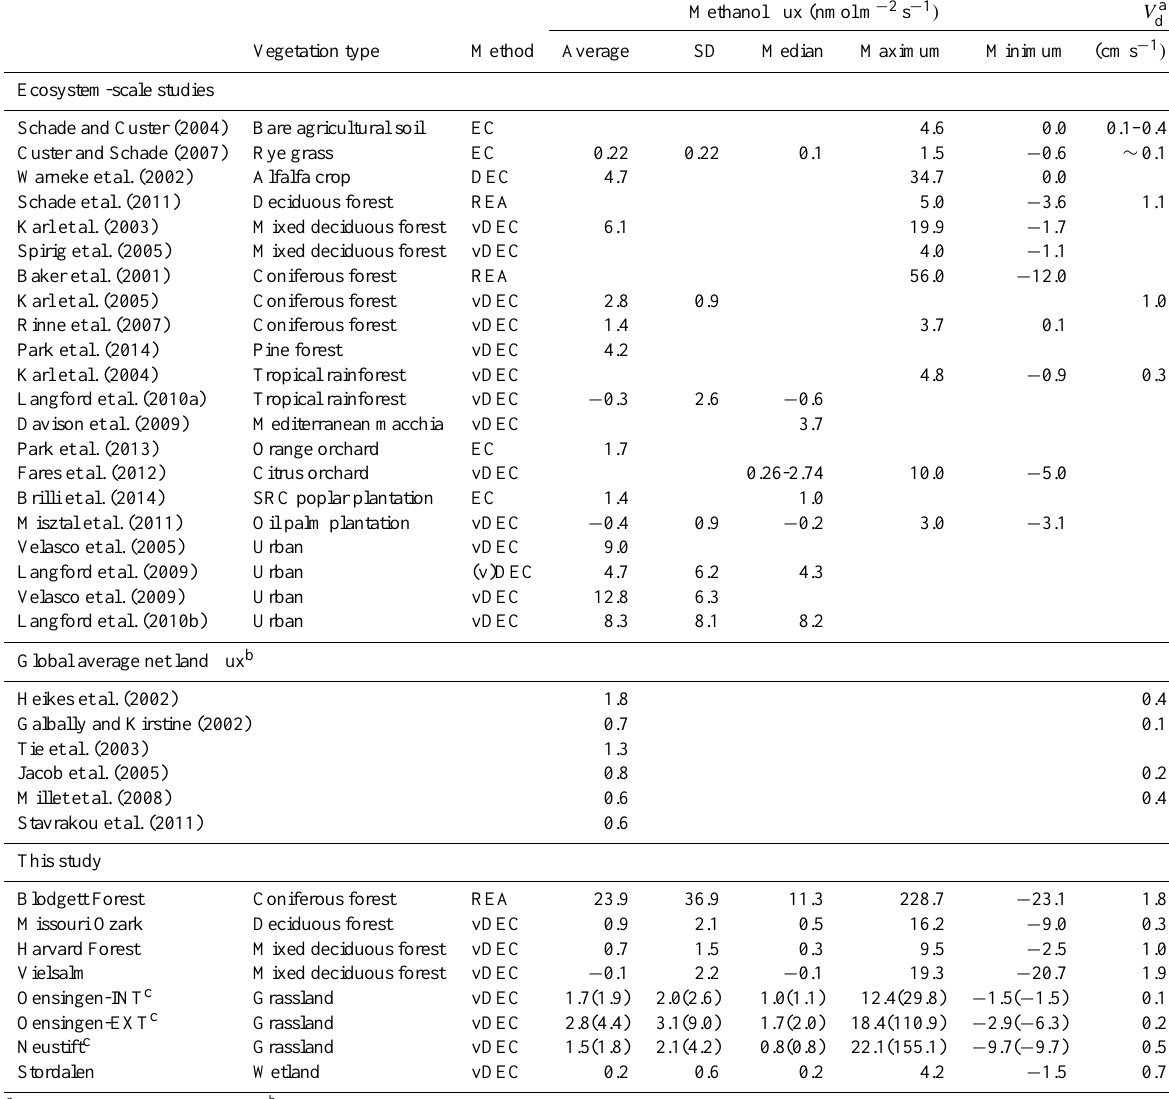
Table 2. Literature survey of micrometeorological methanol flux studies and the net land methanol flux derived from global budget studies compared to the results of the present